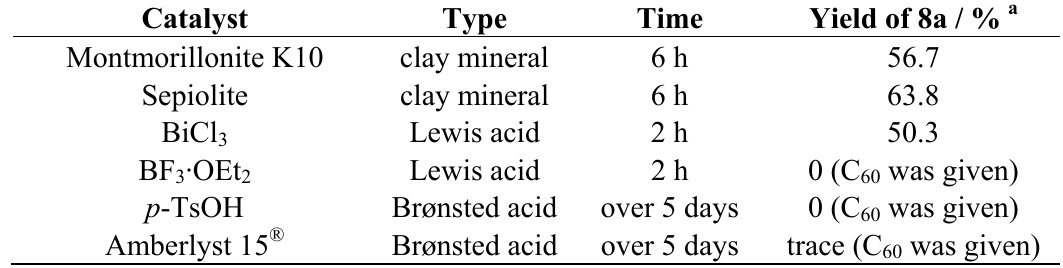
a Isolated yields, estimated from HPLC areas. Reaction condition: C